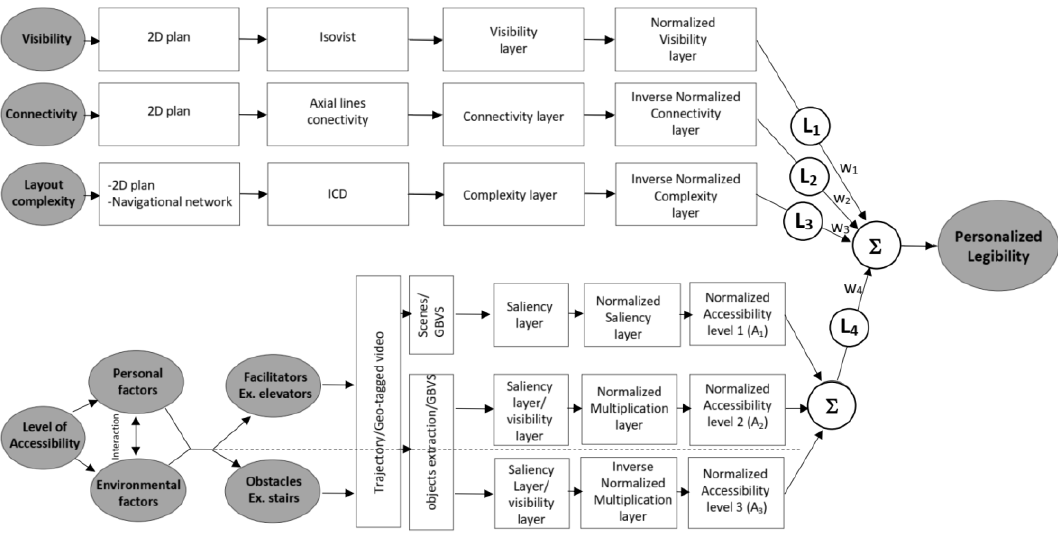
Figure 4. Estimation of personalized legibility of an indoor environment for people with motor disabilities (PWMD).